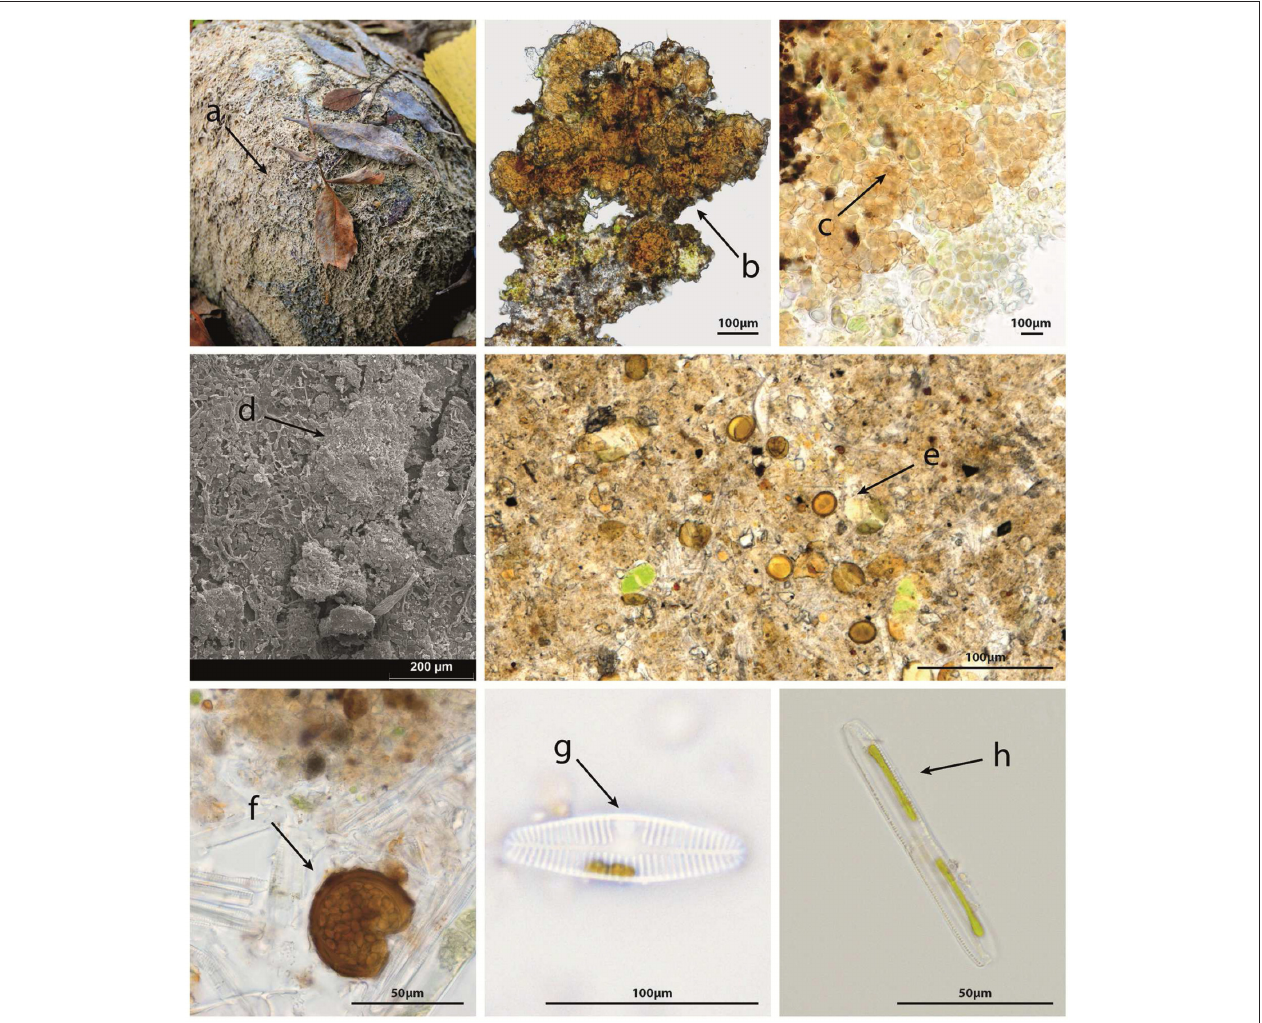
FIGURE 3 | Cell resistance structures in biofilms during the non-flow phase. Structures observed in the epilithon. (A) Bleached dry biofilm, (B) general view of the crust formation, (C) enlarged membrane of encrusting algae and change in color, (D) SEM image of the crust; (E) spores; (F) a resistant spore of Oedogonium sp. Adaptations in the epipsammon and hyporheos: (G,H) chloroplast reduction in diatom